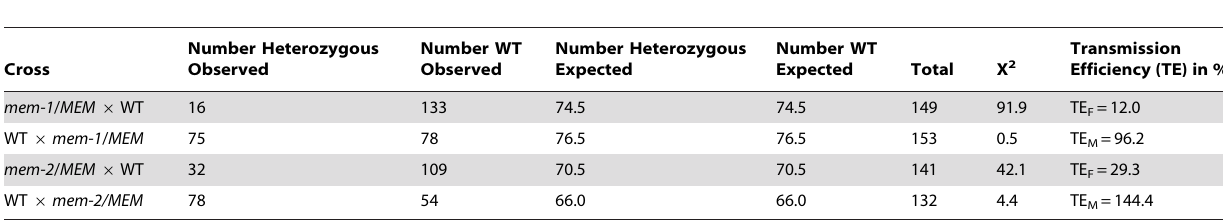
Table 2. Transmission efficiencies (TE) of mem-1 and mem-2 alleles.